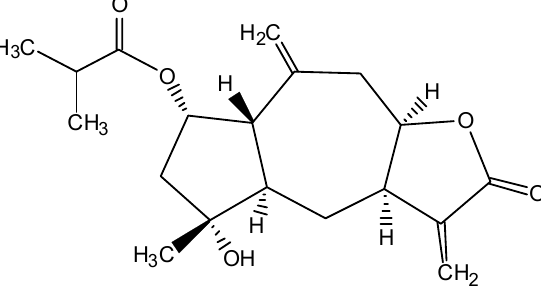
Figure 1. Chemical structure of IF isolated from Centipeda minima